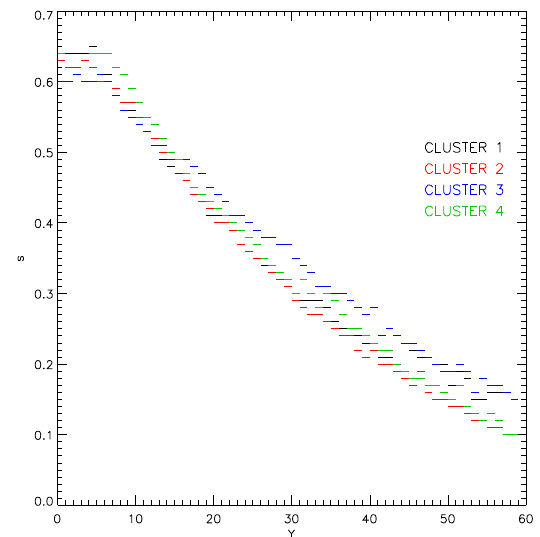
Fig. 6. Rank-ordered multifractal spectra for a typical Cluster pass in the